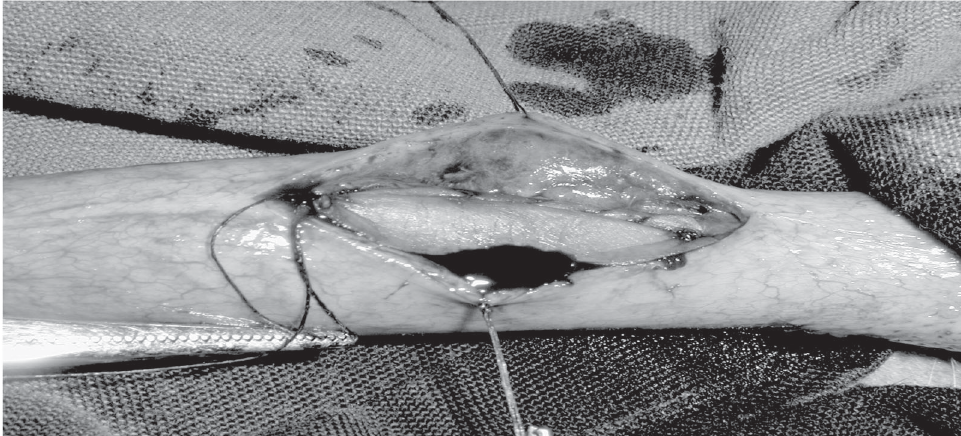
Figure 1. Bovine pericardium patch sutured to correct the urethral defect induced in a